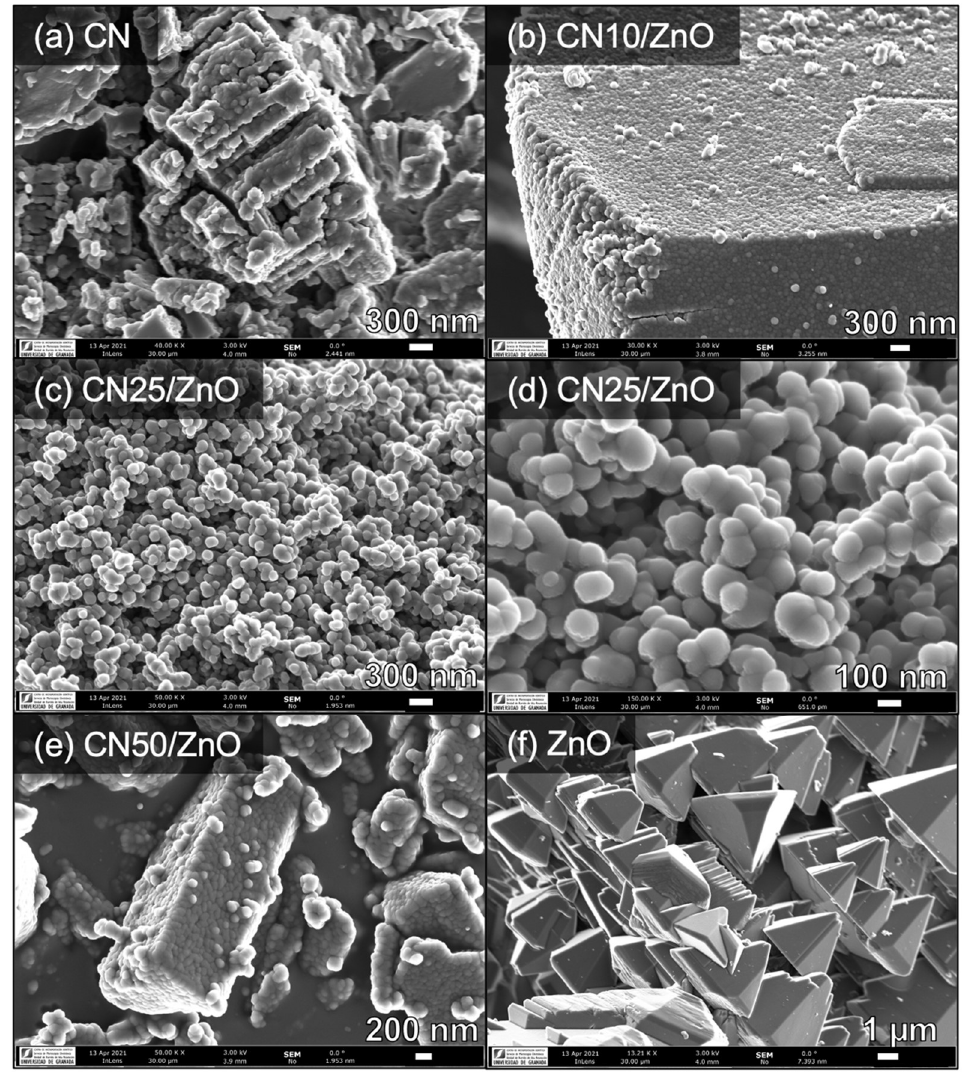
Figure 2. SEM micrographs of ( a ) pure CN, ( b ) CN10/ZnO, ( c , d ) CN25/ZnO, ( e ) CN50/ZnO, and ( f ) pristine ZnO.